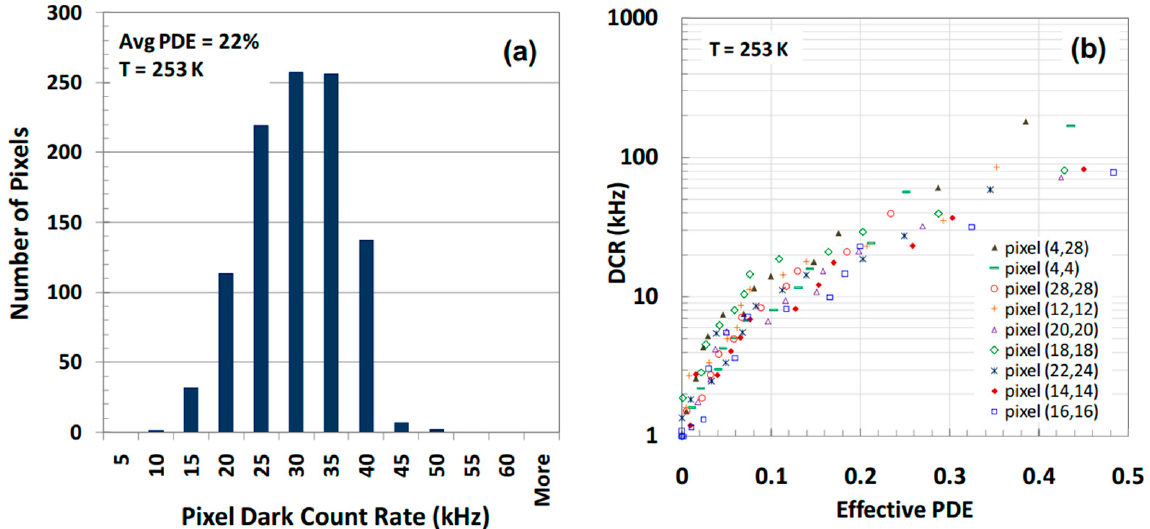
Figure 53. ( a ) Pixel DCRs distribution for the InGaAs/InP FPAs at 1.55 μ m; ( b ) SPDE-dependent DCRs. Reproduced with permission from [107], IEEE, 2010.